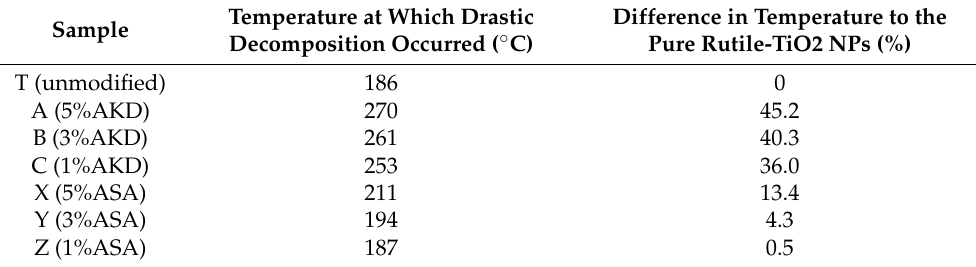
Table 3. Effects of surfactant content and type on thermal